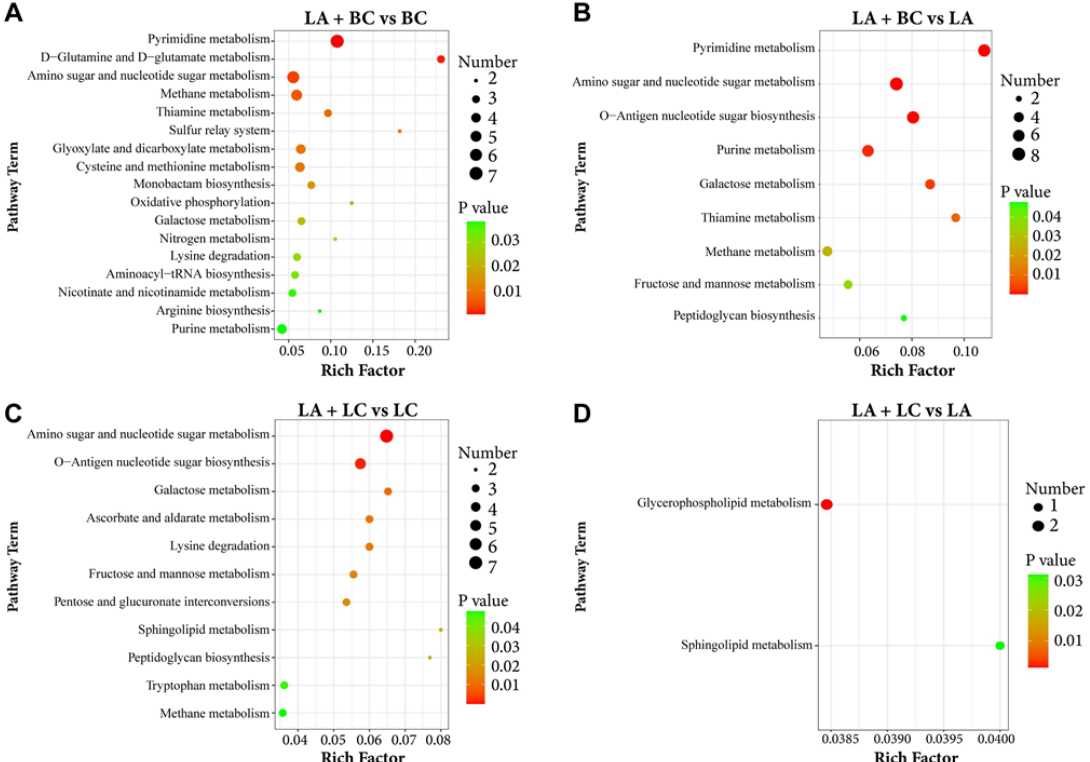
Figure 6. Analysis of KEGG enrichment pathway between different bacterial cultures p < 0.05. ( A ) Lysobacter antibioticus 13-6 and Bacillus cereus BT-23 co-culture (LA+BC) vs. B. cereus BT-23 (BC). ( B ) L. antibioticus 13-6 and B. cereus BT-23 co-culture (LA+BC) vs. L. antibioticus 13-6 (LA). ( C ) L. antibioticus 13-6 and L. capsici ZST1-2 co-culture (LA+LC) vs. L. capsici ZST1-2 (LC). ( D ) L. antibioticus 13-6 and L. capsici ZST1-2 co-culture (LA+LC) vs. L. antibioticus 13-6